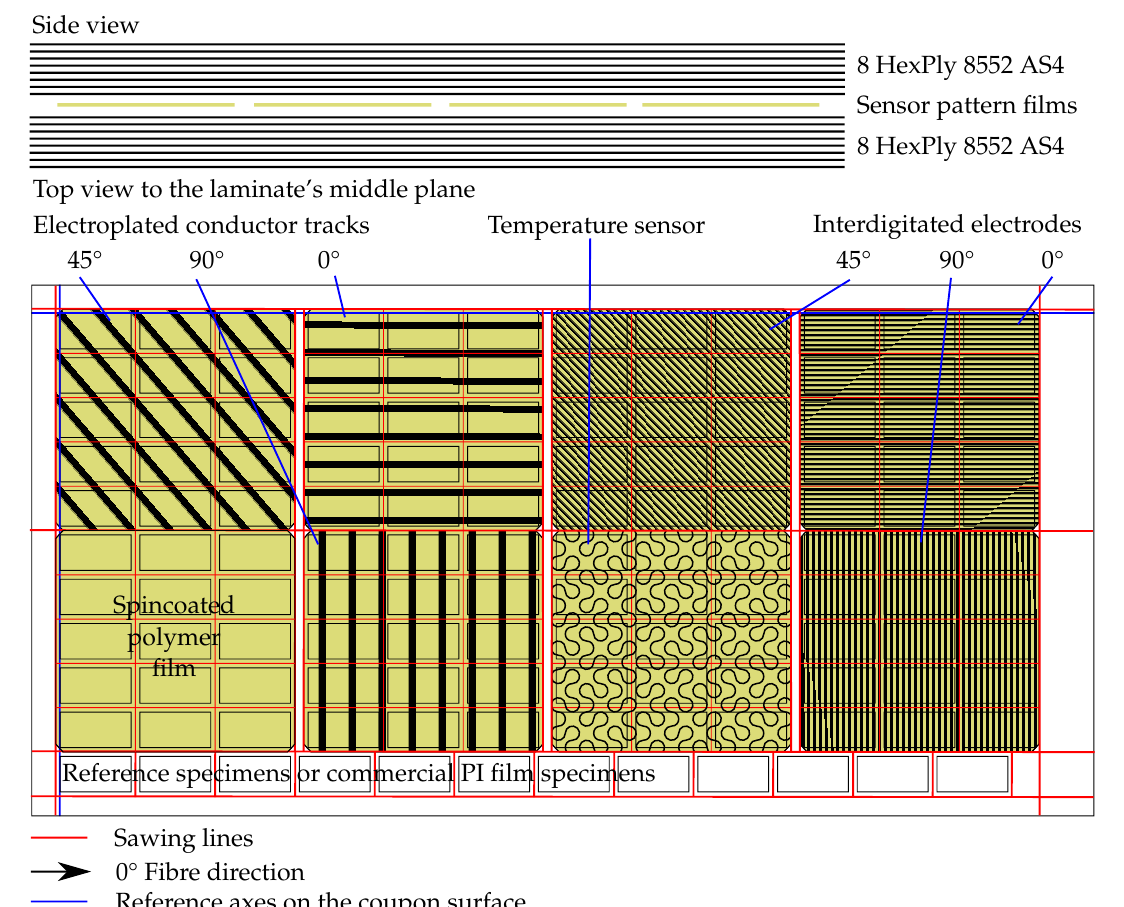
Figure 4. Stacking sequence, cutting plan and film placement in the ILS coupons. In the coupons with PEI films, the stripe on the side was used for reference specimens without any integrated film, and in the coupon with PI specimens, the stripe on the side was used for specimens with an integrated 50 µm thick Kapton film. The sensor patterns are shown to illustrate how the individual sensor pattern films lie in the laminate and are not to